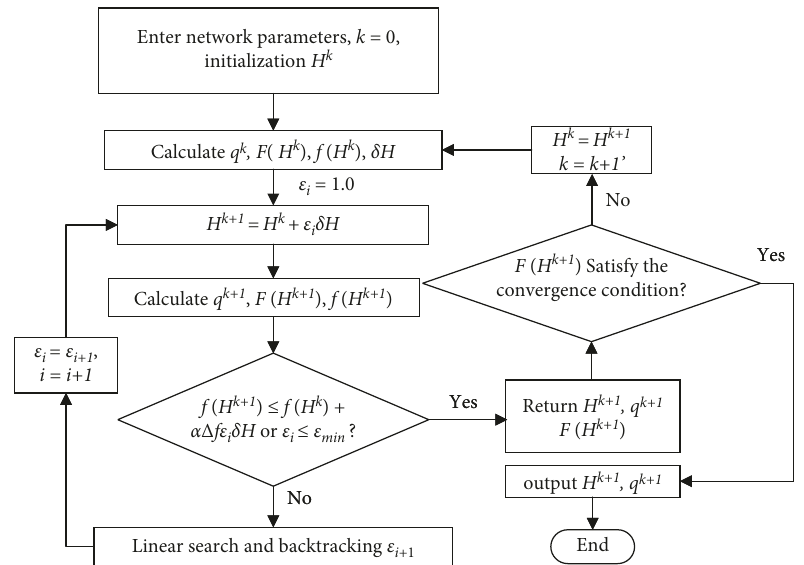
Figure 1: Flow chart of the modified post-earthquake hydraulic analysis simulation algorithm.